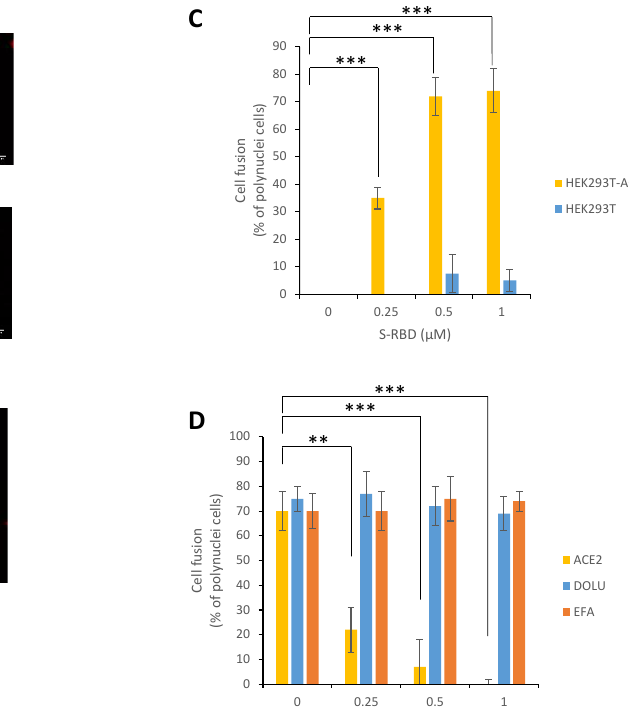
Figure 6. S-RBD meditated cell fusion. Increasing concentrations of SARS-CoV-2 S-RBD fragment were added to either HEK293T or HEK293-ACE2 cells for 0–16 h before epifluorescence microscopy (1 µ M RBD and 16 h’ time point in ( A ) and magnification in ( B )). The number of cell fusions observed after incubation with increasing concentration of RBD has been quantified by measuring the number of polynuclei cells ( C ). the effect of soluble ACE2, Efavirenz and Dolutegravir has been analyzed by adding the protein or drugs simultaneously with the RBD and by quantifying the cell fusion 16 h after treatment ( D ). Data were obtained from at least two independent experiments and are reported as means ± SD. At